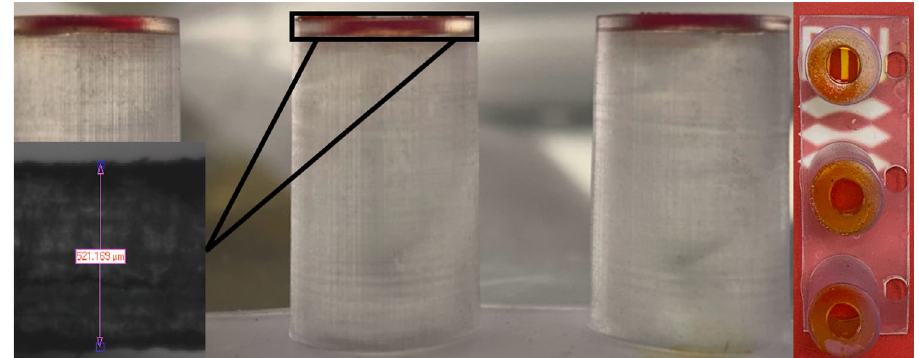
Figure 2. 3D-printed Gelatin-inserts (Ø: d = 8.8 mm; a = 4 mm); dip-cast with red food dye colored gelatin membrane. Left The thickness of the 3D-printed material at the bottom, 521 µm) was measured with a 6.5-fold zoom lens USB 3 camera of contact angle device (Dataphysics, Germany). Right Transparency of a dry gelatin membrane.